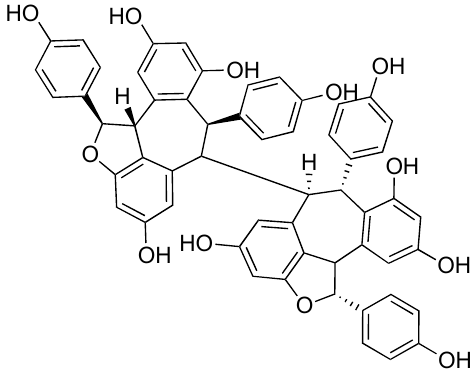
Figure 10. (-)-Hopeaphenol, a tetramer of resveratrol isolated from rainforest plants.